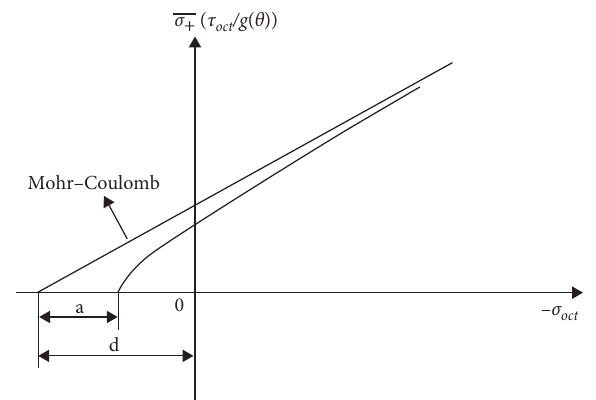
Figure 2: The hyperbolic function to approximate the Mohr–Coulomb failure criterion for axisymmetric compression in the meridian